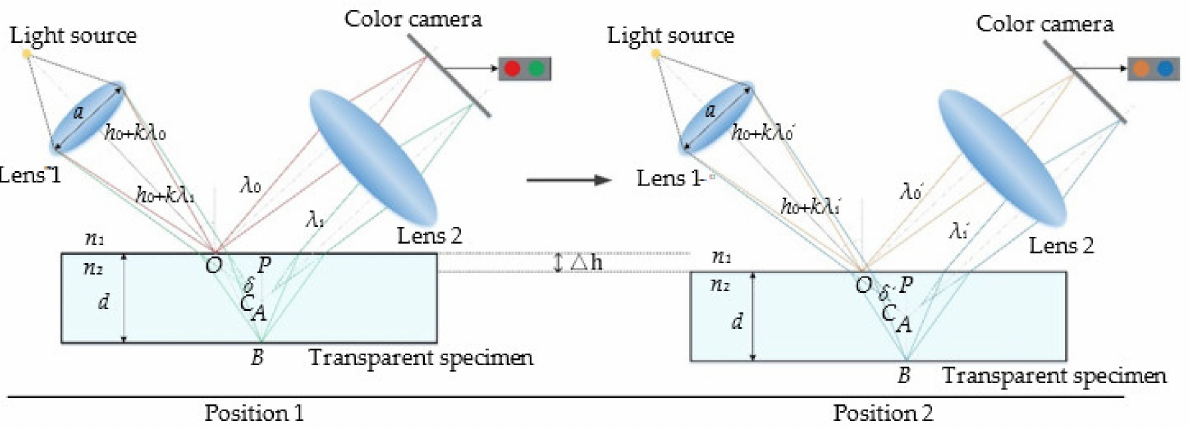
Figure 12. The light reflected from the upper and lower surfaces of the transparent sample in different positions.